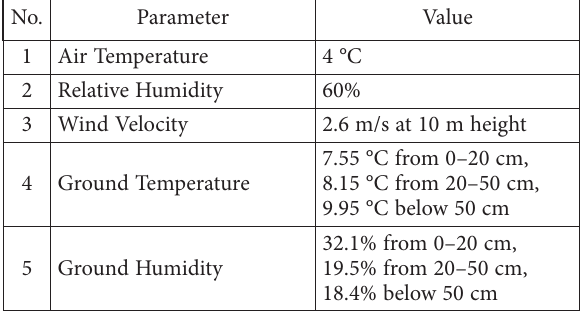
Table 1. Meteorological inputs for the configuration file of the ENVI-met model on simulation